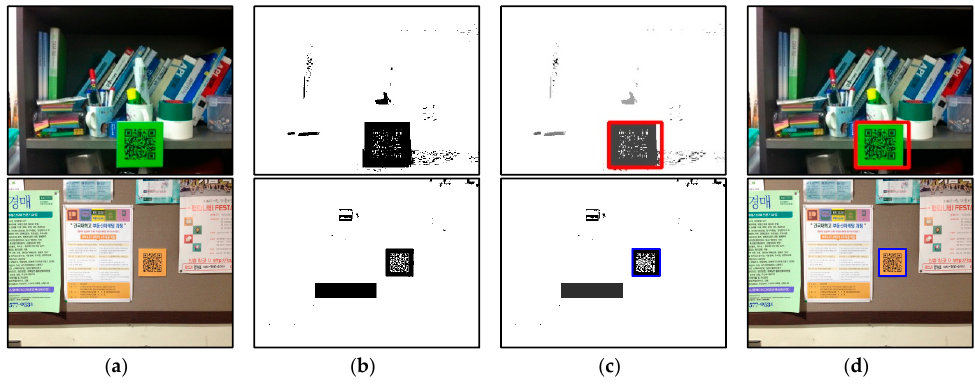
Figure 7. Process for QR code localization: ( a ) Input images; ( b ) Discretized results; ( c ) Labelling results; ( d ) Detected QR codes.